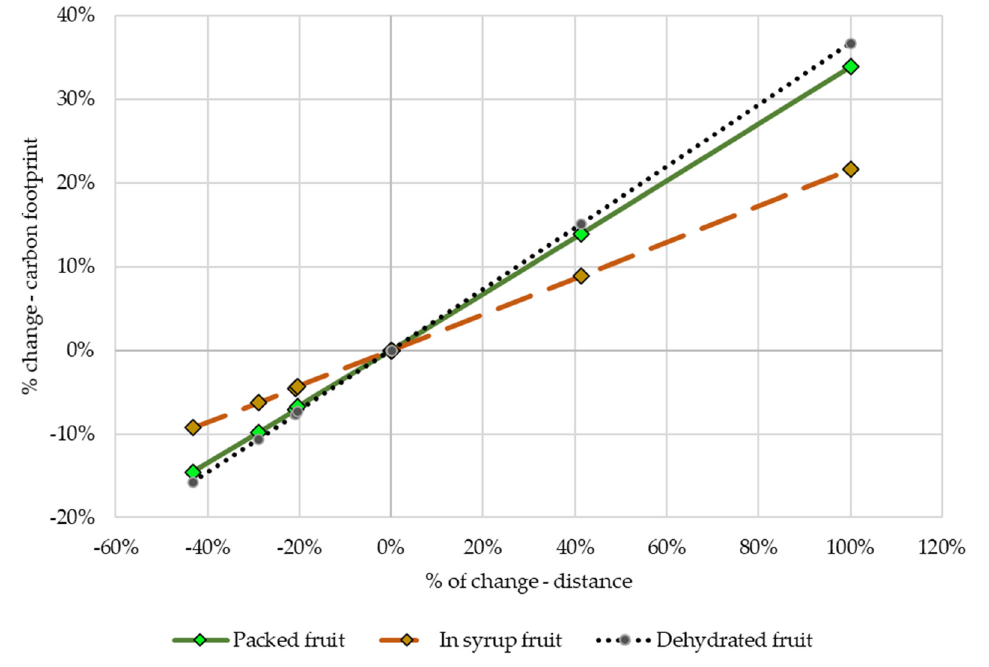
Figure 14. Transport sensitivity analysis for the carbon footprint category.